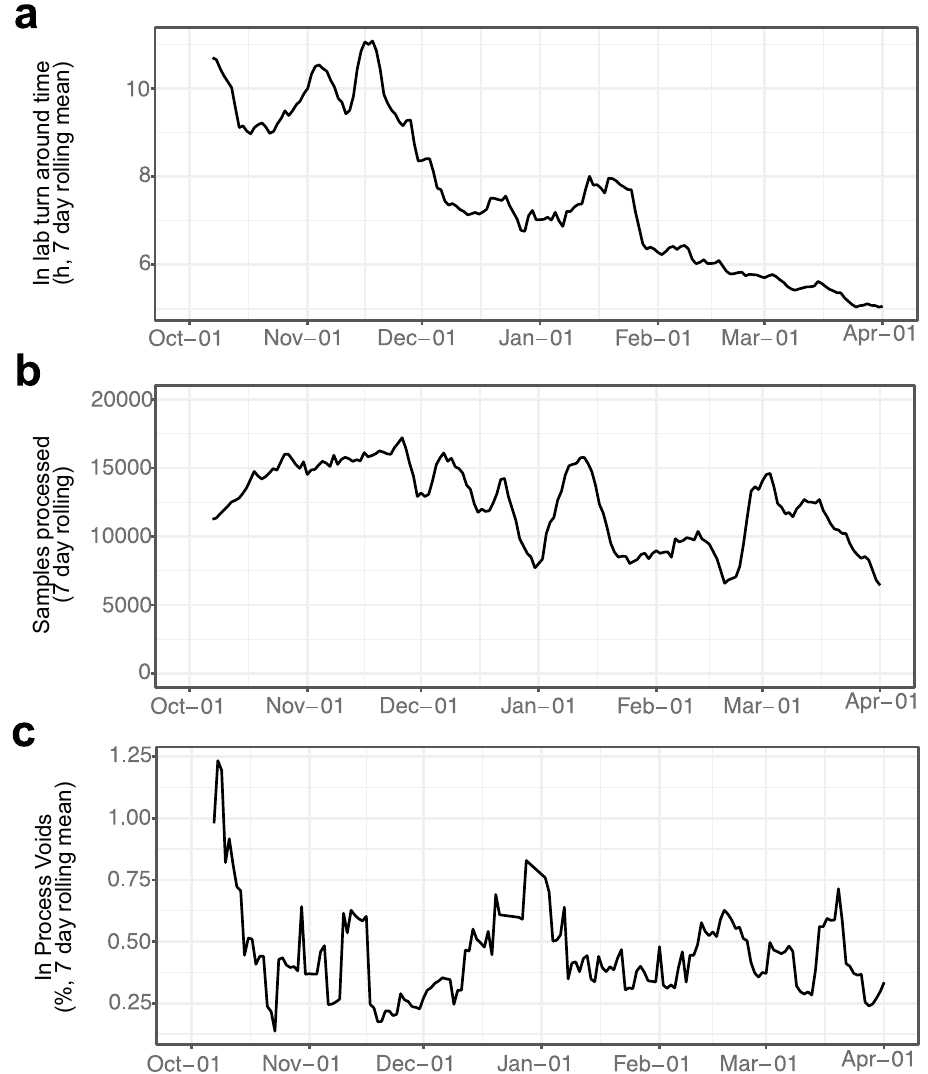
Figure 4. Lab TAT, samples processed, and quality control of the CCTC from October 2020–March 2021. ( a ) 7-day rolling mean of the lab TAT. ( b ) 7-day rolling mean of the total daily sample number processed. ( c ) 7-day rolling mean of the in-process voids within the lab. Figure prepared using R with ggplot2 v 3.3.2 [CRAN— Package ggplot2